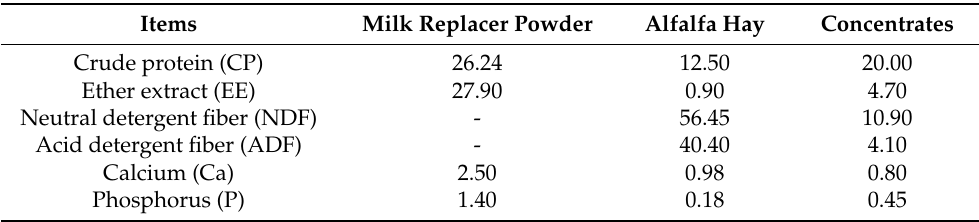
Table 1. Nutritional components of milk replacer, alfalfa hay and supplementary concentrate (dry matter basis) (Unit: